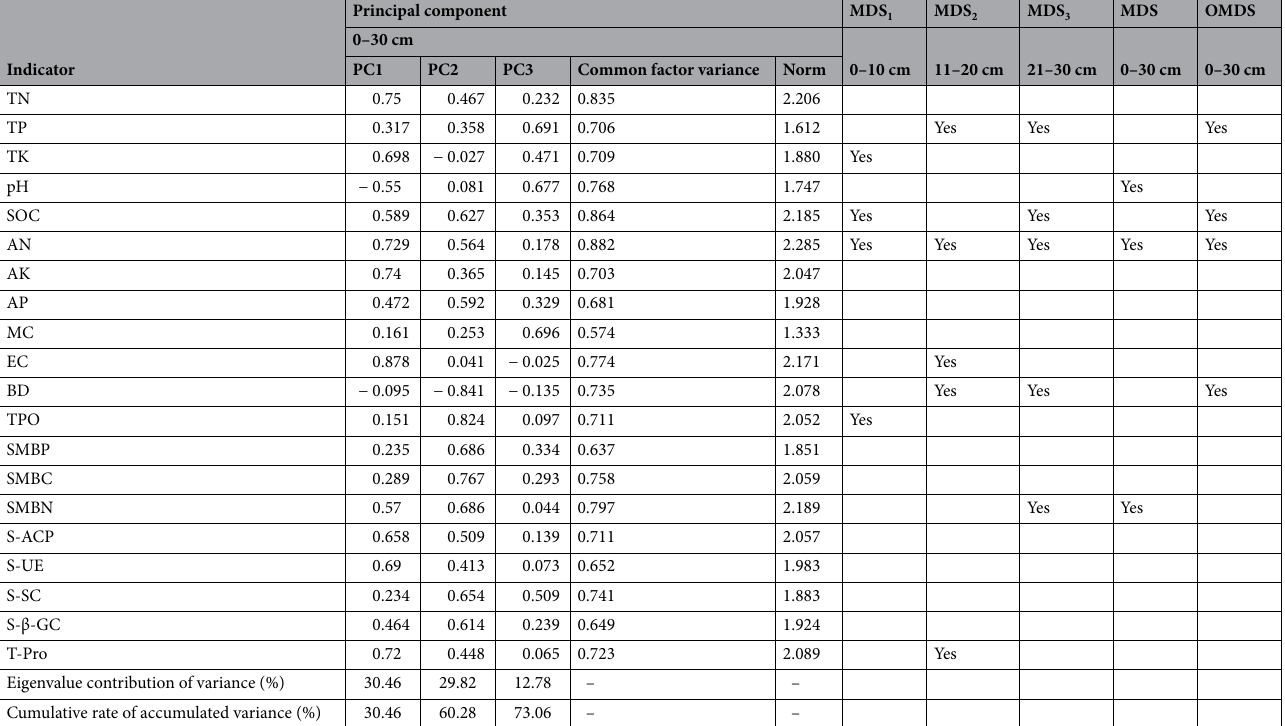
Table 3. Principal component analyses results of soil quality